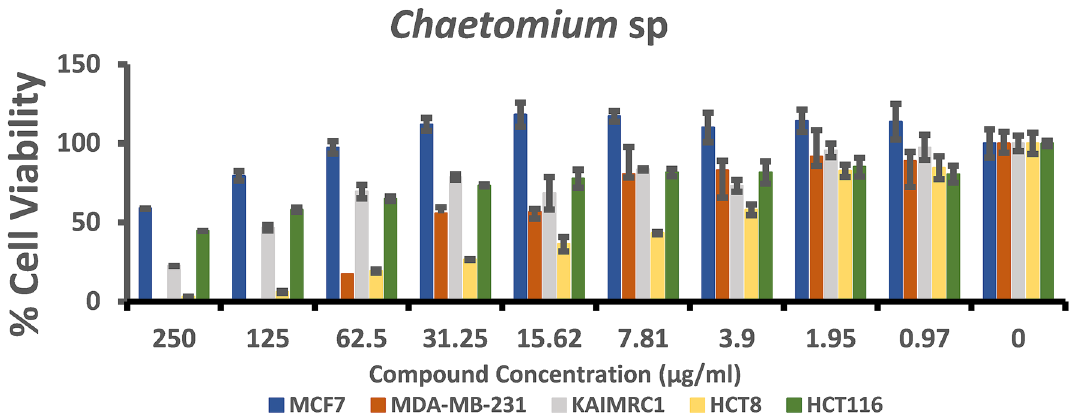
Figure 6. A summary of the biological activity of Chaetomium sp extracts on MCF7, MDA-MB-231 and KAIMARC1 breast carcinoma cells as well as HCT8 and HCT116 colorectal carcinoma cells after 96 h of exposure. Columns in the histograms represent the mean ± SD (n = 3) of fungal crude extracts tested at nine different concentrations ranging from 0.97 to 250 μg/ml. The columns represent variations among various concentrations of